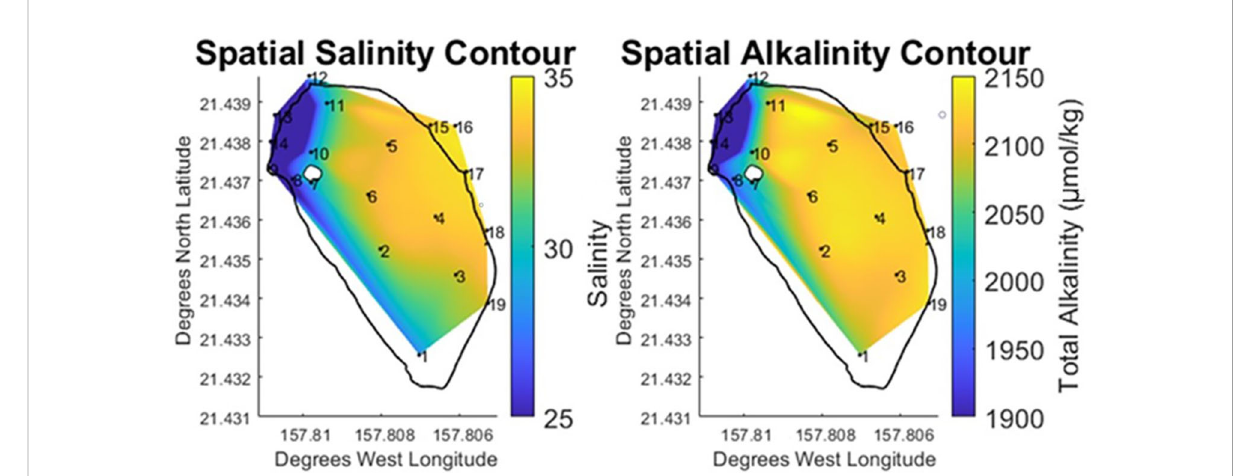
FIGURE 4 Vertically and temporally averaged contours of horizontal variability in Salinity and Total Alkalinity at He ‘ eia Fishpond during the study period. Stations IDs (numbered in black) are plotted on contour to show sampling